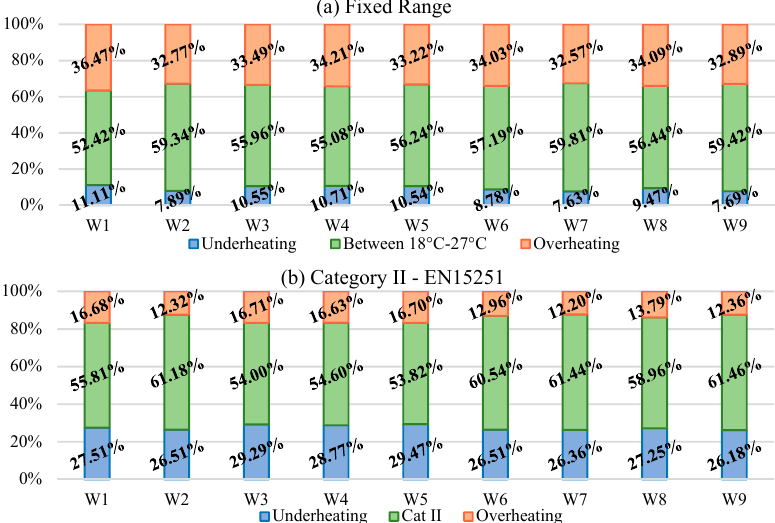
Figure 8. Comfort rates according to the static ( a ) and the adaptive ( b ) approach for different wall configurations.